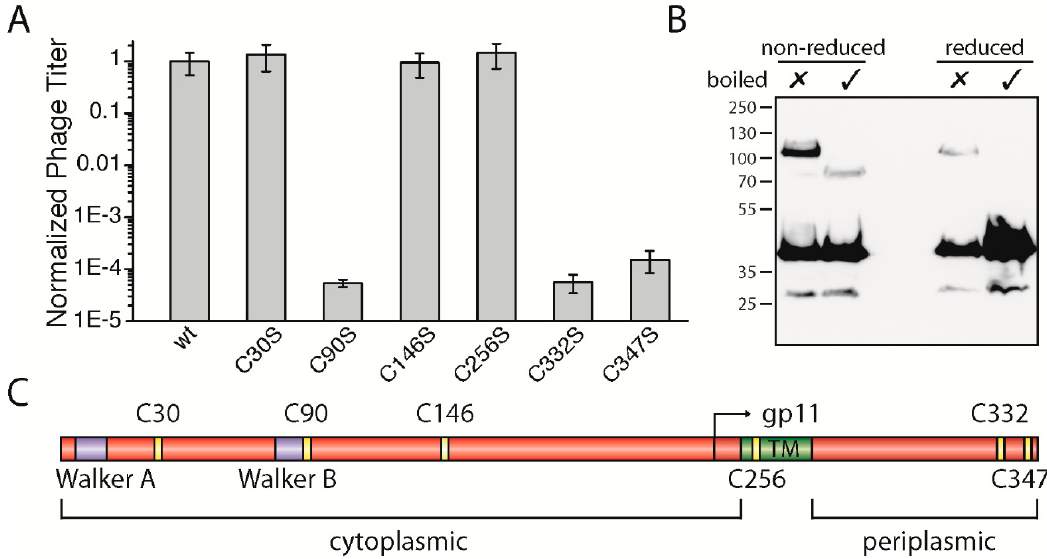
Figure 3. ( A ) Quantified phage titer in in vivo complementation assays of geneI cysteine mutants. The amount of phages produced using plasmid-encoded wild-type gp1 was normalized to 1 and compared with gp1 mutants, plotted on a logarithmic scale. While the substitution of cysteine with the chemically similar residue serine had no effect on protein function in position 30 (C30S), 146 (C146S), and 256 (C256S), mutations in positions 90 (C90S), 332 (C332S), and 347 (C347S) severely affected the production of phages. ( B ) Western blot analysis showing the migration pattern of His-tagged gp1 quadruple mutant (C30S, C90S, C146S, C256S) under reducing and non-reducing conditions. Samples were either not boiled ( ✗ ) or boiled ( ✓ ). ( C ) Schematic representation of the protein gp1 with its internal ORF gp11. The two Walker motifs, Walker A and Walker B, are shown in purple, the TM in green, and the cysteine residues are depicted in yellow. Numbers refer to the residue of the cysteines within gp1/gp11.